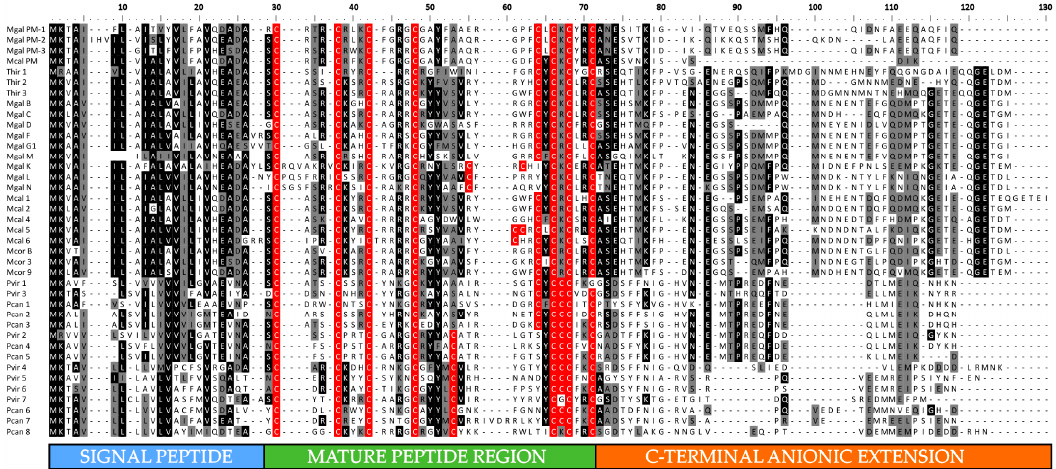
Figure 3. Multiple sequence alignment of full-length mytilins precursor peptides. The signal peptide, mature peptide and C-terminal anionic extension regions are highlighted. Residues conserved in > 50% sequences are shaded and the cysteine residues possibly engaged in disulfide bonds are marked with a red background. Note that some nearly identical sequences have been omitted from the alignment for simplicity’s sake. PM: pseudomytilin; Mcal: M. californianus ; Mcor: M. coruscus ; Mgal: M. galloprovincialis ; Pcan: Perna canaliculus ; Pvir: P. viridis .